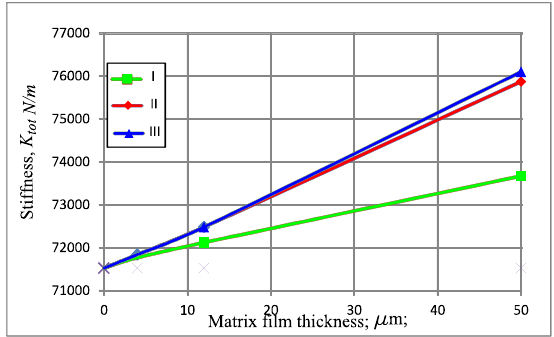
Fig. 5. Variations of the total normal element stiffness versus the thickness of the matrix film for different properties of the